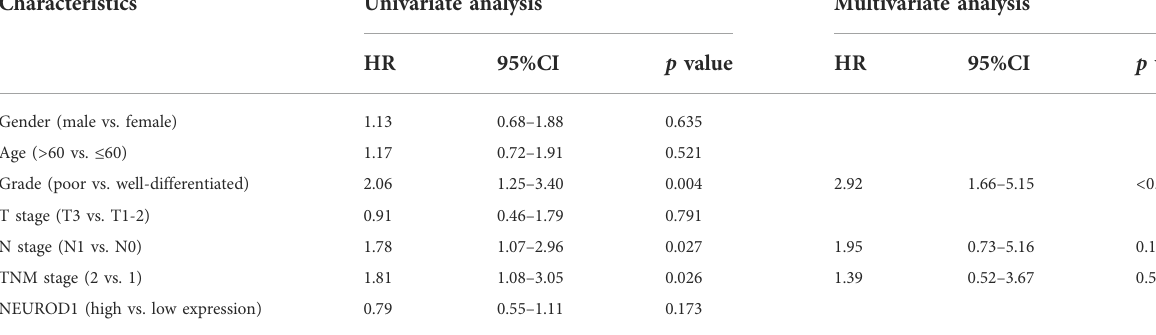
TABLE 5 Univariate and multivariate analysis of prognostic factors in